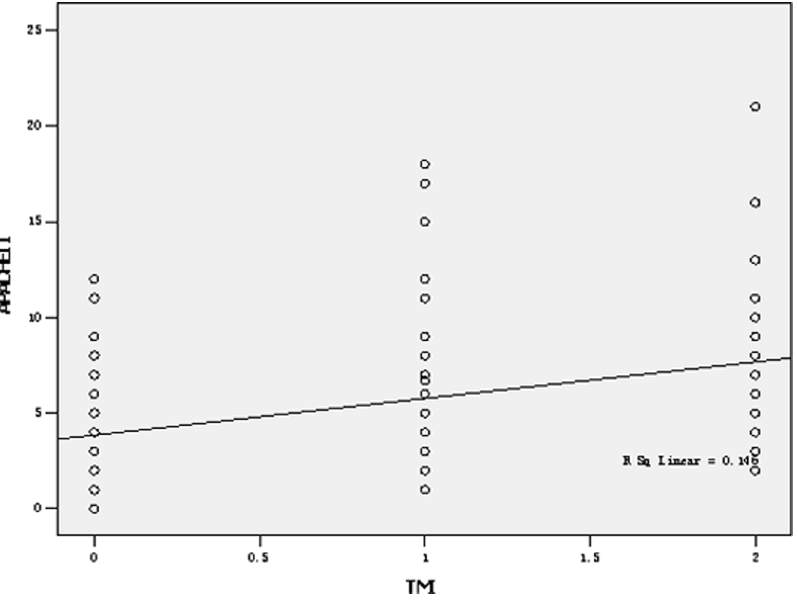
Figure 9. Spearman’s correlation between the APACHE II and TMI (r=0.384, P=0.000). doi:10.1371/journal.pone.0093687.g009 PLOS ONE |